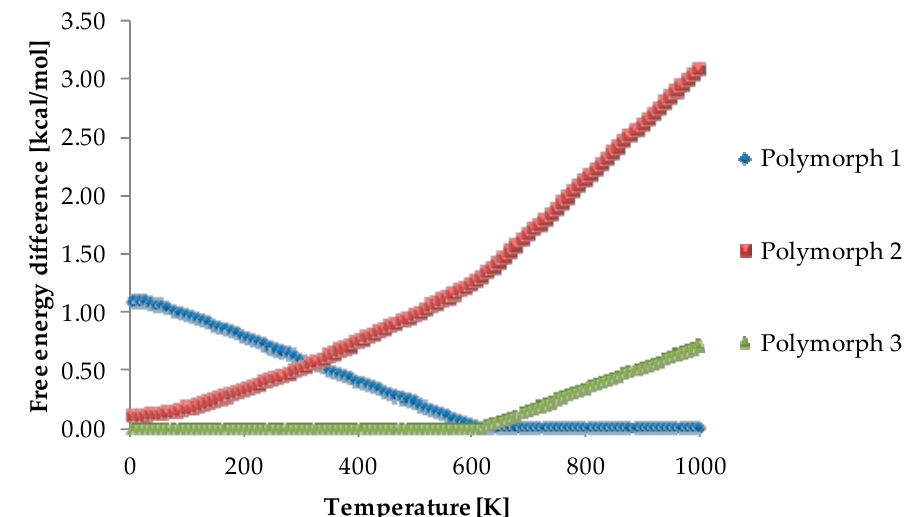
Figure 3. Results of thermodynamics calculations for three polymorphs of nootropic drug, piracetam. The energy of the lowest energy form at given T is, at that T, the reference one and its value is set to zero. Using periodic DFT calculations it was possible to determine the order of stability of those three studied forms. The calculated results were in agreement with the experimental data, that is the Polymorph 3 is the most stable one at low temperatures until it transforms into Polymorph 1 which is the most stable one at high temperatures. The Polymorph 2 is metastable in the whole temperature range. Source: author’s archive, more details [116].